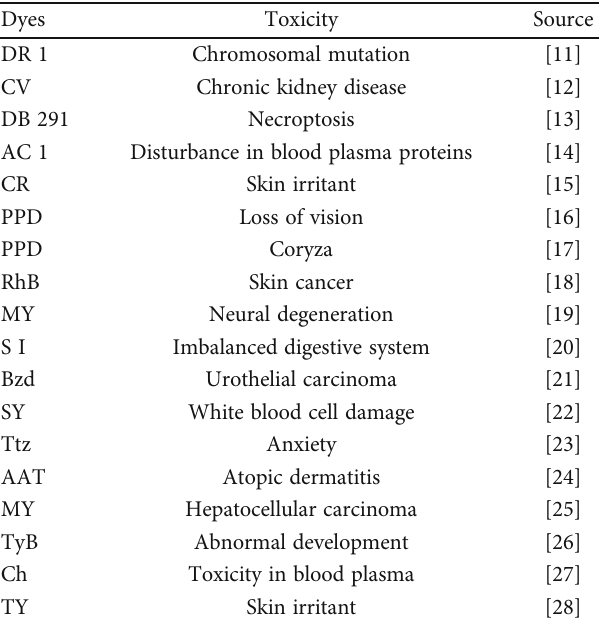
Table 2: Toxic e ff ects of some synthetic colorants on human